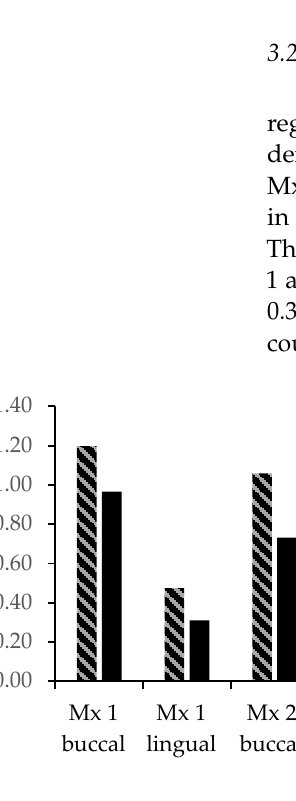
Table 3. Dental Transverse Changes Per Year in Males and Females (*, p < 0.05).